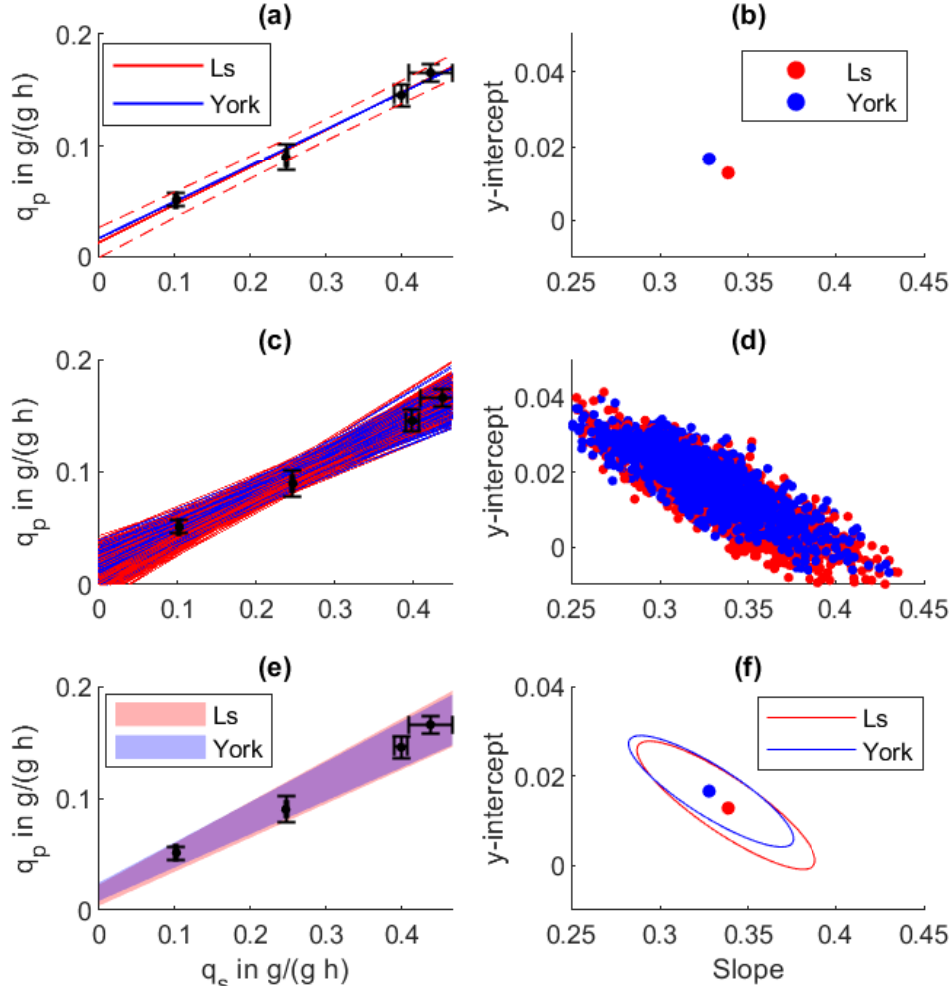
Figure 3. Regression analysis between biomass-specific substrate uptake q s and specific production rate q p in an E. coli fed-batch process. ( a ) Regression line and ( b ) regression parameters from normal least squares (LS) and York regression (York). ( c , d ) One-thousand Monte Carlo regressions based on the uncertainties of the specific rates. ( e , f ) The obtained 68.3% parameter confidence intervals and resulting prediction